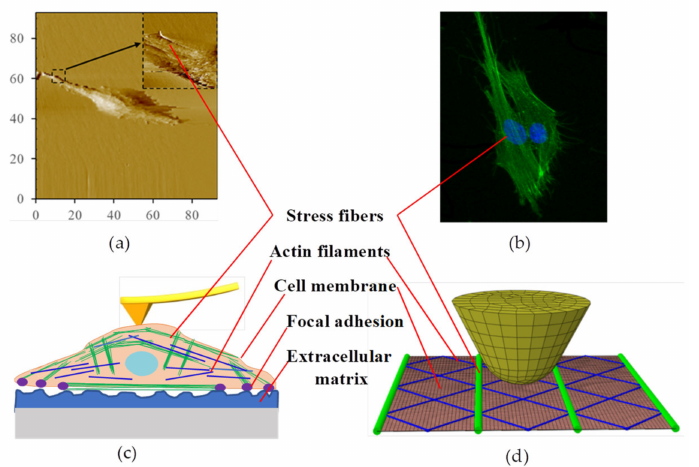
Figure 4. The finite element analysis model and simulation result. ( a ) AFM topography image of a single NIH3T3 cell. ( b ) Immunofluorescence image of NIH3T3 cells. ( c ) The schematic of a cell adhering to the substrate. ( d ) The finite element analysis